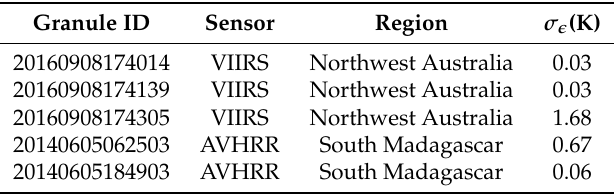
Table 3. Noise standard deviation of the SST images